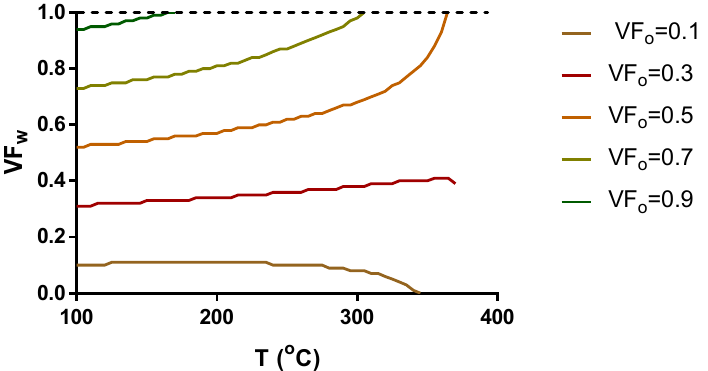
Figure 2. Change in volume fraction of reactor filled with liquid water VF w ( V w / V R ) as a function of temperature for various initial liquid water volume fractions ( VF o ).